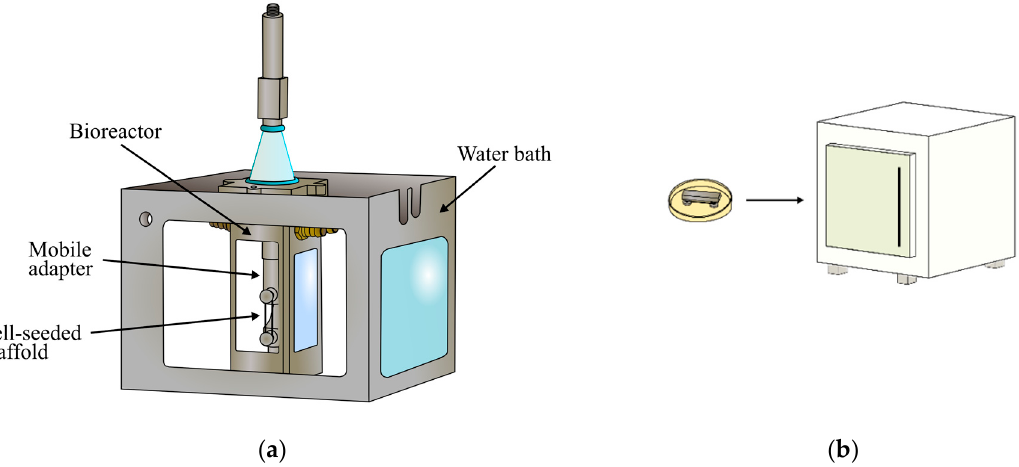
Figure 4. ( a ) Diagram of bioreactor inside water bath. ( b ) Static cell-seeded scaffold to be placed inside the incubator.